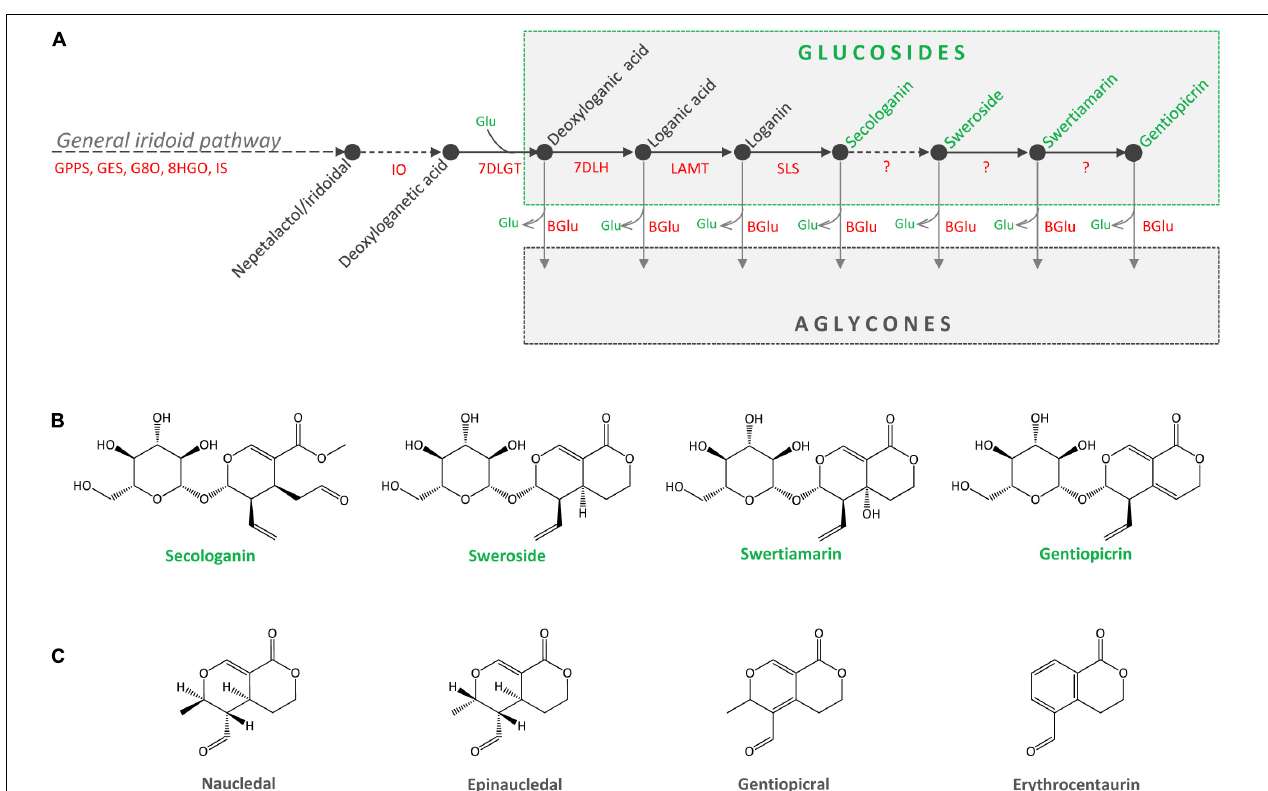
FIGURE 1 | (A) Proposed metabolic pathway of secoiridoid glucosides in Centaurium erythraea . Unknown enzymes of the biosynthetic pathway are marked with the question mark. GPPS, geranyl diphosphate synthase; GES, geraniol synthase; G8O, geraniol-8-oxidase; 8HGO, 8-hydrohygeraniol oxidoreductase; IS, iridoid synthase; IO, iridoid oxidase; 7DLGT, 7-deoxyloganetic acid glucosyltransferase; 7DLH, 7-deoxyloganic acid hydrolase; LAMT, loganic acid O-methyltransferase; SLS, secologanin synthase; BGlu, beta glucosidase. (B) Major secoiridoid glucosides of C. erythraea, secologanin, sweroside, swertiamarin, and gentiopicrin. (C) Aglycones of sweroside (naucledal and epinaucledal), swertiamarin and gentiopicrin (gentiopicral and